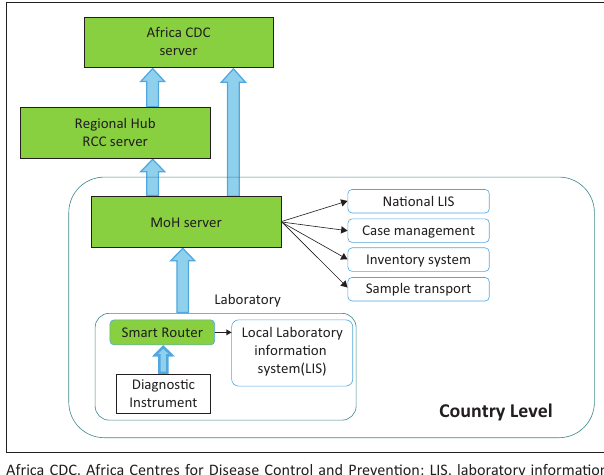
FIGURE 1: Potential flow of information between national, regional and Africa CDC. At each level, the server manages what information and triggering conditions determine further